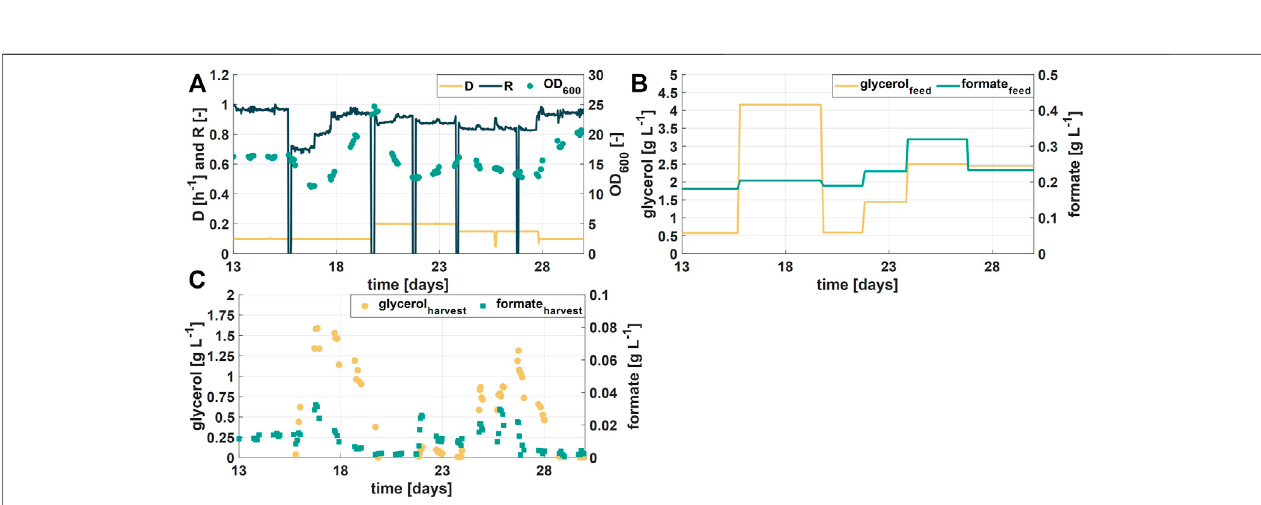
FIGURE 3 | Comparison of speci fi c growth rates between H. mediterranei , H. organivorans , and the novel mixed culture in the industrial residual process brine. Additionally, H. mediterranei was grown in synthetic medium with 100 and 150 g L-1 NaCl.